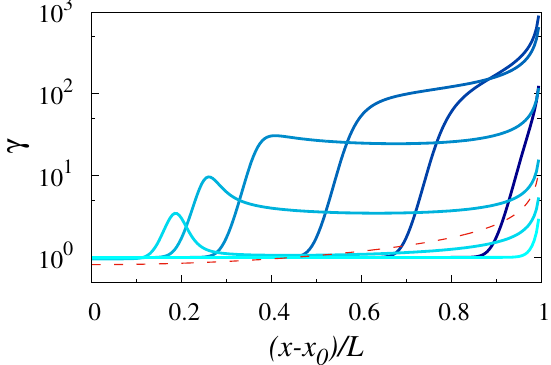
Figure 2. Coefficient of variation γ of the FPTD for a Gaussian polymer translocating across a varying-section, left–right symmetric ( L 1 = L /2) channel, as a function of ( x − x 0 ) / L . The channel geometry was characterized by h 0 / L = 0.25 and h 1 / h 0 = 0.8 (see Equation (2)). The number N of beads in a polymer was fixed, N = 90. The control parameter, x 0 / L , assumes values of 0.1,0.3,0.5,0.7,0.8,0.85 and 1, with lighter colors corresponding to larger values of x 0 / L . The dashed line indicates the coefficient of variation of the FPTD in a constant cross-section